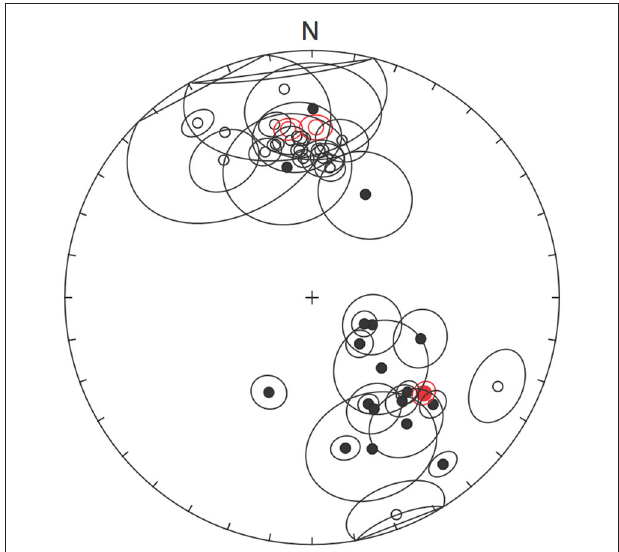
FIGURE 8 | Site-mean directions of the Itararé Group rocks plotted on a stereonet: solid (open) symbols are projections on the lower (upper) hemisphere; black and red symbols are for sedimentary and igneous rocks, respectively. See text for